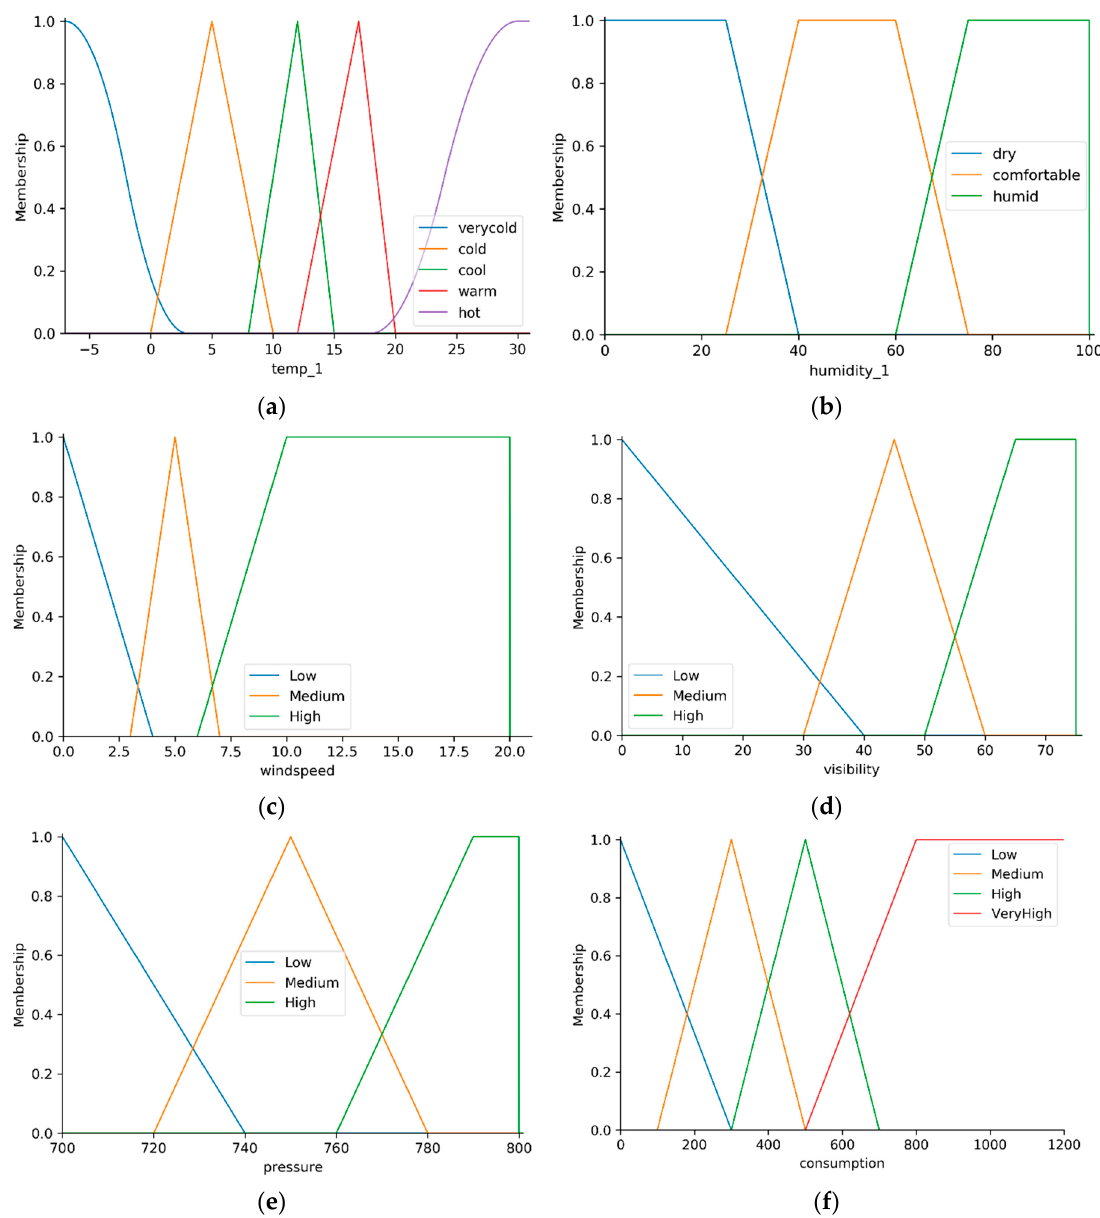
Figure 5. Membership functions for each input and output variable with different color coding for each linguistic term: ( a ) Temperature; ( b ) Humidity; ( c ) Wind speed; ( d ) Visibility; ( e ) Pressure; ( f ) Appliance Consumption.